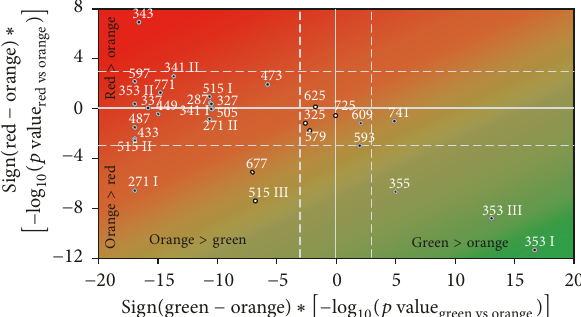
Figure 3: Results of Wilcoxon tests comparing orange tomatoes with green (horizontal axis) and red (vertical axis) tomatoes. The 𝑝 values are presented in log ± 3 correspond 10 -scale (dotted lines at to 𝑝 = 0.001 ) multiplied by the sign of difference: in right lower corner are compounds with the highest values in green tomatoes, in left upper corner are compounds with the highest values in red tomatoes, and in left lower corner are compounds with the highest values in orange tomatoes (right upper corner corresponds to nonexisting compounds with higher values in both green and red tomatoes). Filled circles denote compounds different in green and red tomatoes ( 𝑝 < 0.001 ). Points’ labels present compounds’ m/z values and are explained in Table